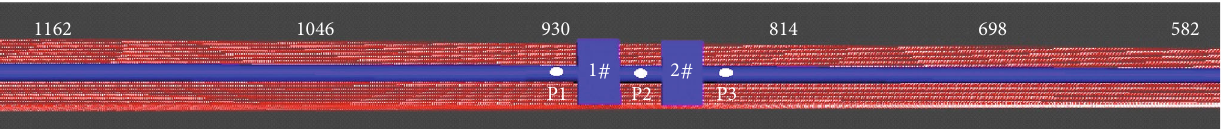
Figure 6: Geometric model and